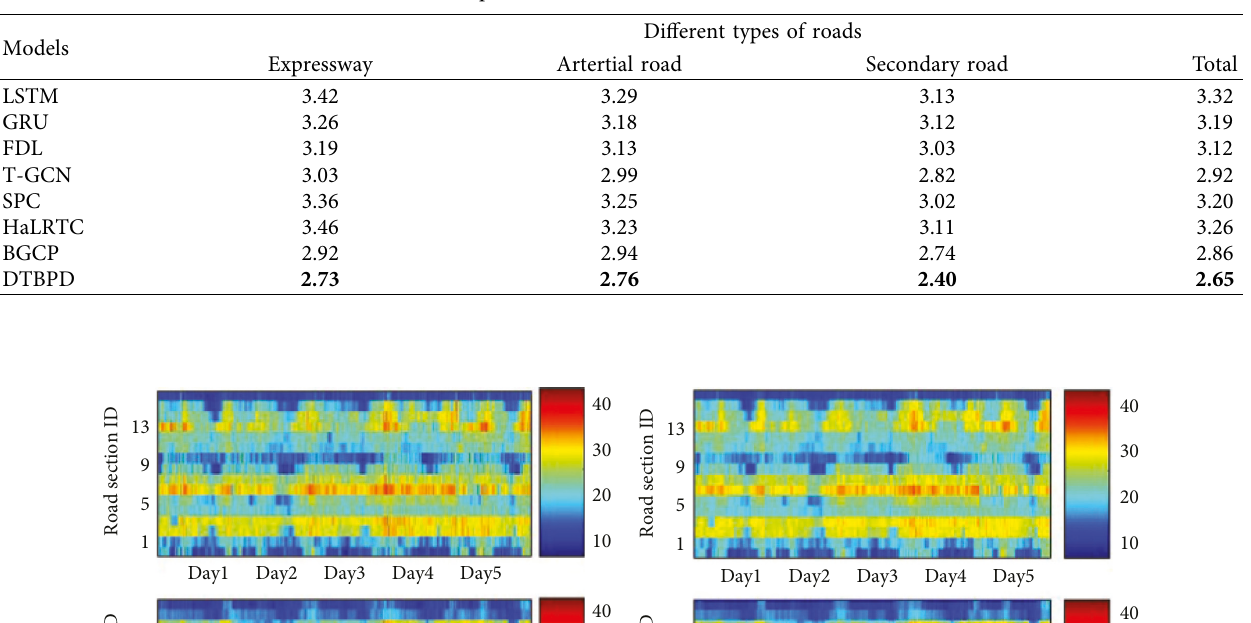
Table 3: The overall performance of different models in terms of